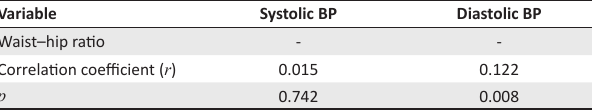
TABLE 5: Correlation analysis of WHR and BP of the